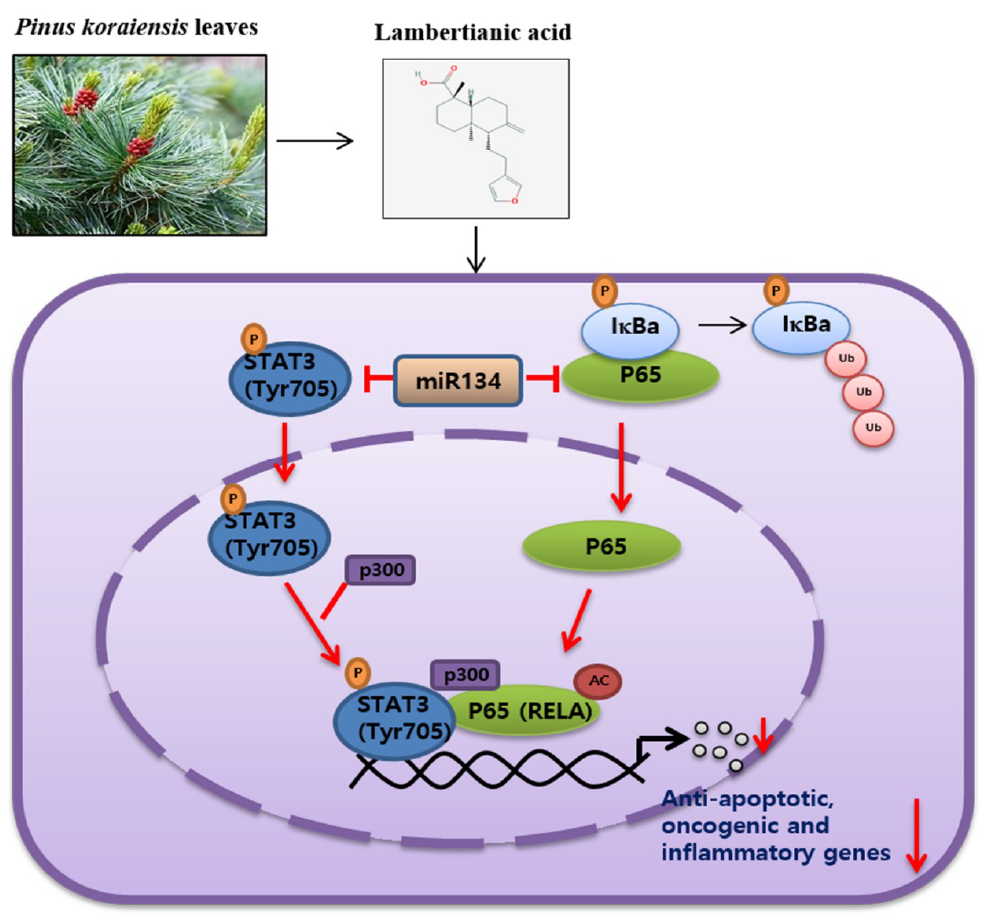
Figure 7. Schematic diagram on the apoptotic mechanism of LA in cancer cells via the miRNA-134- Schematic diagram on the apoptotic mechanism of LA in cancer cells via the mediated inhibition of STAT3 and RelA/p65 acetylation. miRNA-134-mediated inhibition of STAT3 and RelA / p65